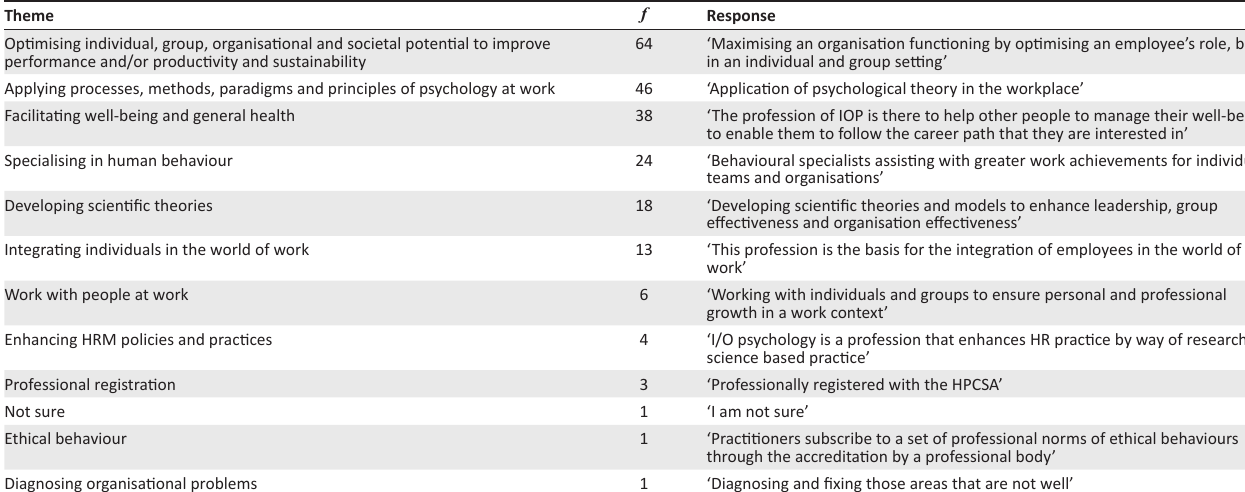
TABLE 2: Definition of IOP.